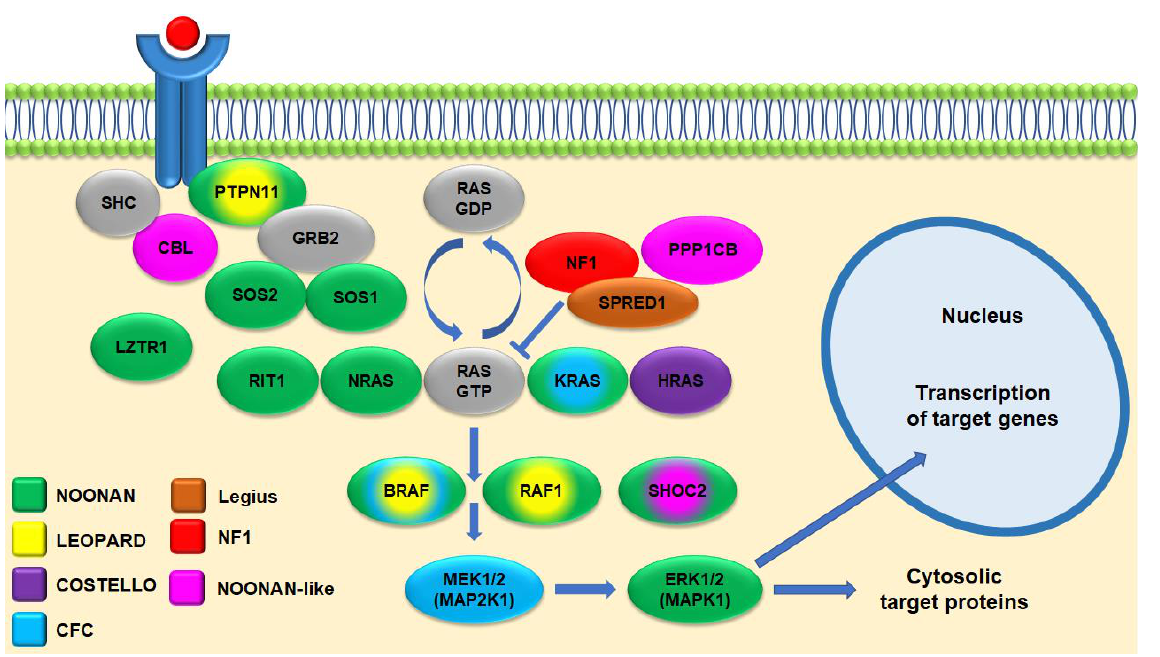
Figure 1. Schematic representation of the RAS/MAPK pathway in RASopathies. Germinal mutations in genes encoding different components of the pathway can cause overlapping phenotypes, color coded according to the legend.